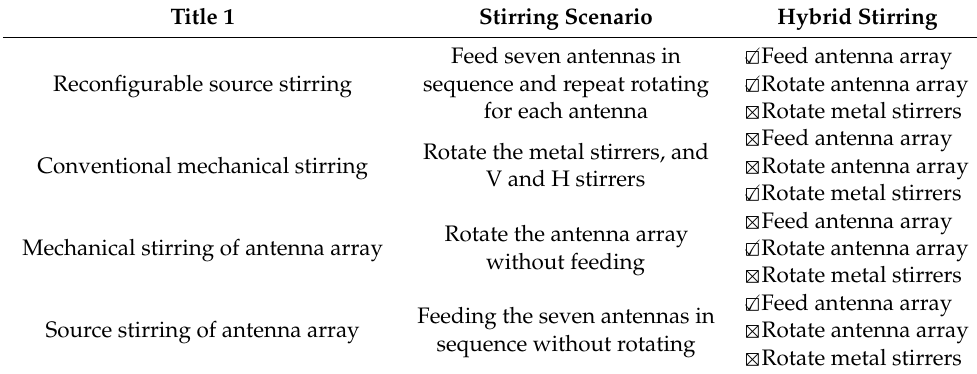
Table 1. Description of the stirring